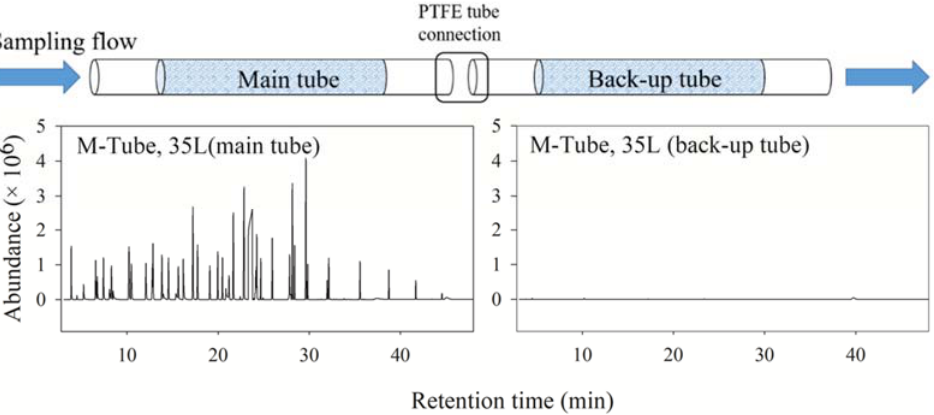
Figure 3. The chromatogram of the main (left) and backup (right) tube of the M ‐ Tube at 35 L retention volume. The inlet gas concentration of total volatile organic compounds was 440 ppbv. For the comparison of GC peaks between the main tube and backup tube, y ‐ axis was shown in the same scale for both chromatograms.